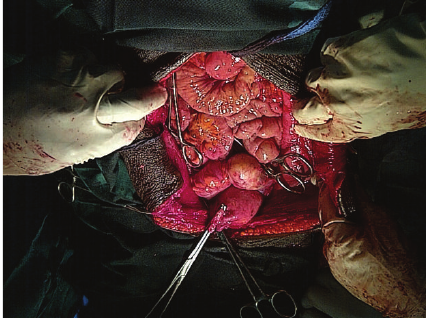
Figure 1: The huge mature ovarian cystic teratoma before excision.